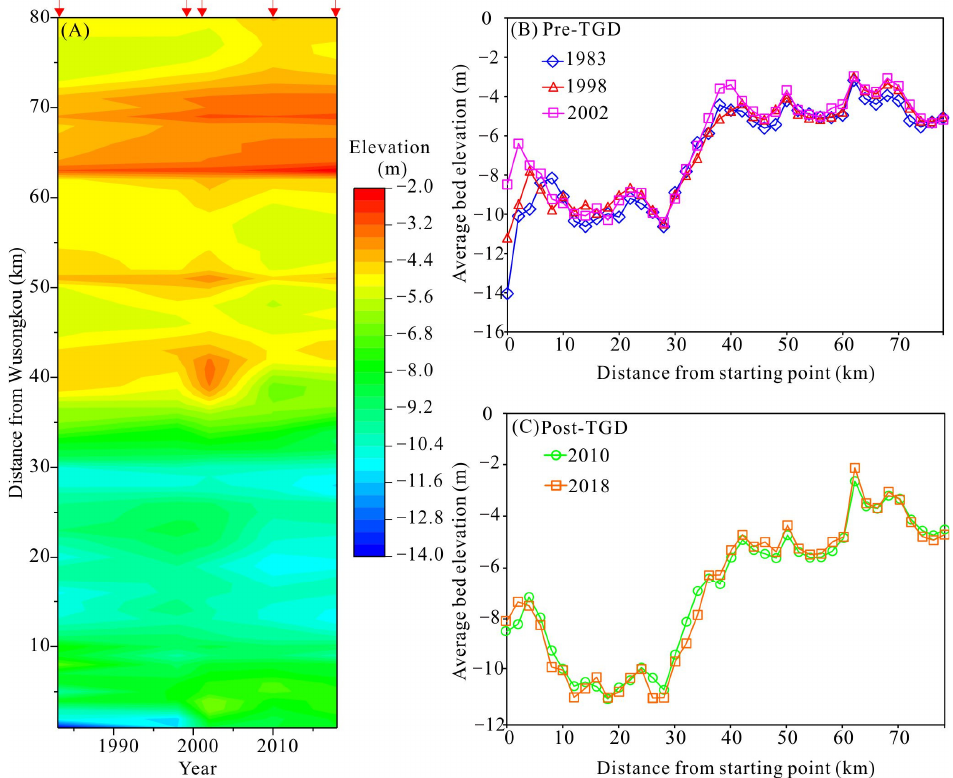
Figure 4. Spatiotemporal variation in bed elevation along the Yangtze estuary channel between 1983 and 2018. ( A ) 3D contour map. Green arrows correspond to the longitudinal profiles shown in pan- els ( B , C ). ( B ) Longitudinal profiles for different points in time before the closure of the Three Gorges Dam. ( C ) Longitudinal profiles for different points in time after the closure of the Three Gorges Dam.